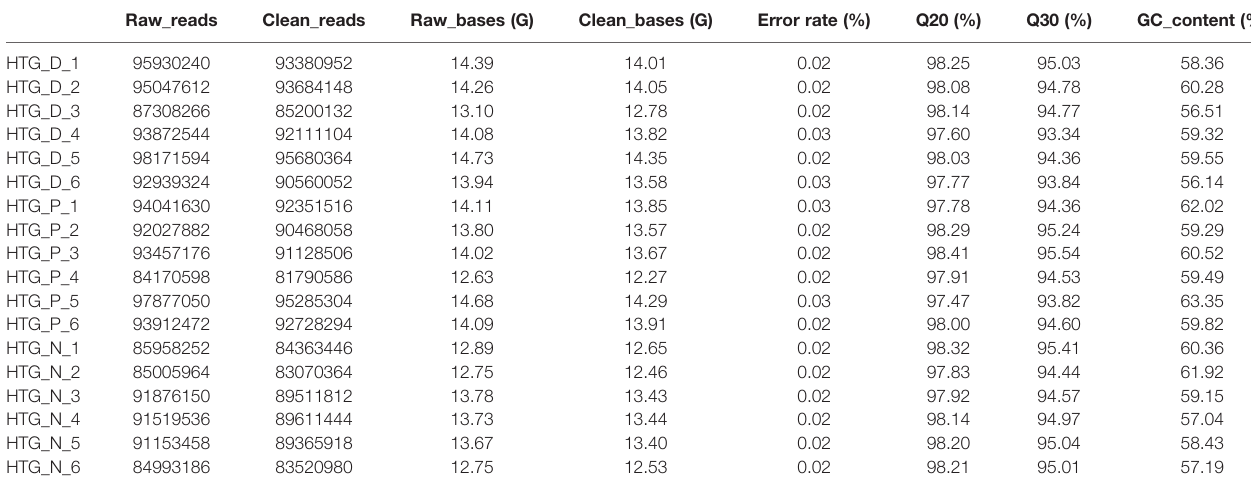
TABLE 2 | Summary of data from RNA sequencing.